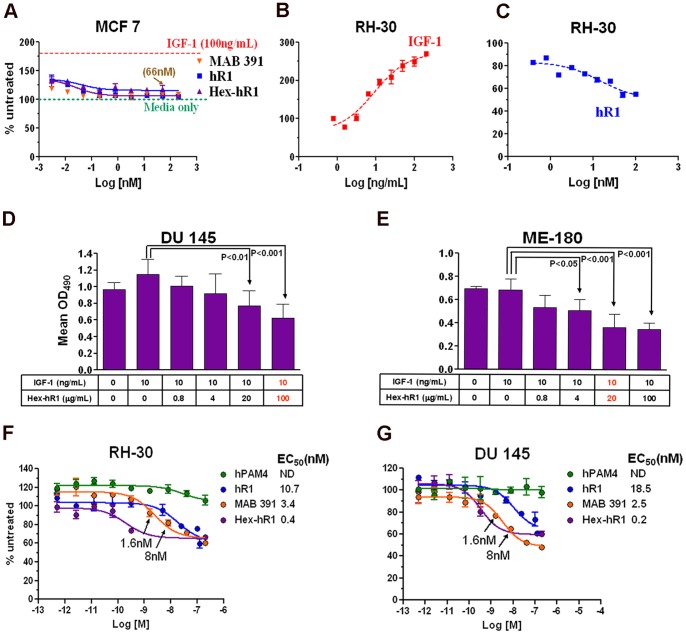
Various cell proliferation studies in serum-free medium as determined by the MTS assay.(A) Lack of growth promotion by MAB391, hR1 or Hex-hR1 on MCF7; (B) Dose-response stimulation of RH-30 proliferation by IGF-1; (C) Sensitivity of RH-30 to hR1; (D) Inhibitory activity of Hex-hR1 observed in DU 145 stimulated with 10 ng/mL of IGF-1 for 72 h; (E) Inhibitory activity of Hex-hR1 observed in ME-180 stimulated with 10 ng/mL of IGF-1 for 72 h; (F) Dose-dependent inhibitory effects of hR1 and Hex-hR1 on proliferation of RH-30 in the presence of 50 ng/mL of IGF-1. MAB391 and hPAM4 were tested in parallel as positive and negative controls, respectively; (G) Dose-dependent inhibitory effects of hR1 and Hex-hR1 on proliferation of DU 145 in the presence of 50 ng/mL of IGF-1. In A, B, C, F and G, the number of viable cells determined for each treated sample was expressed as percent (%) of the untreated control. EC50 values were calculated and indicated in (F) and (G).